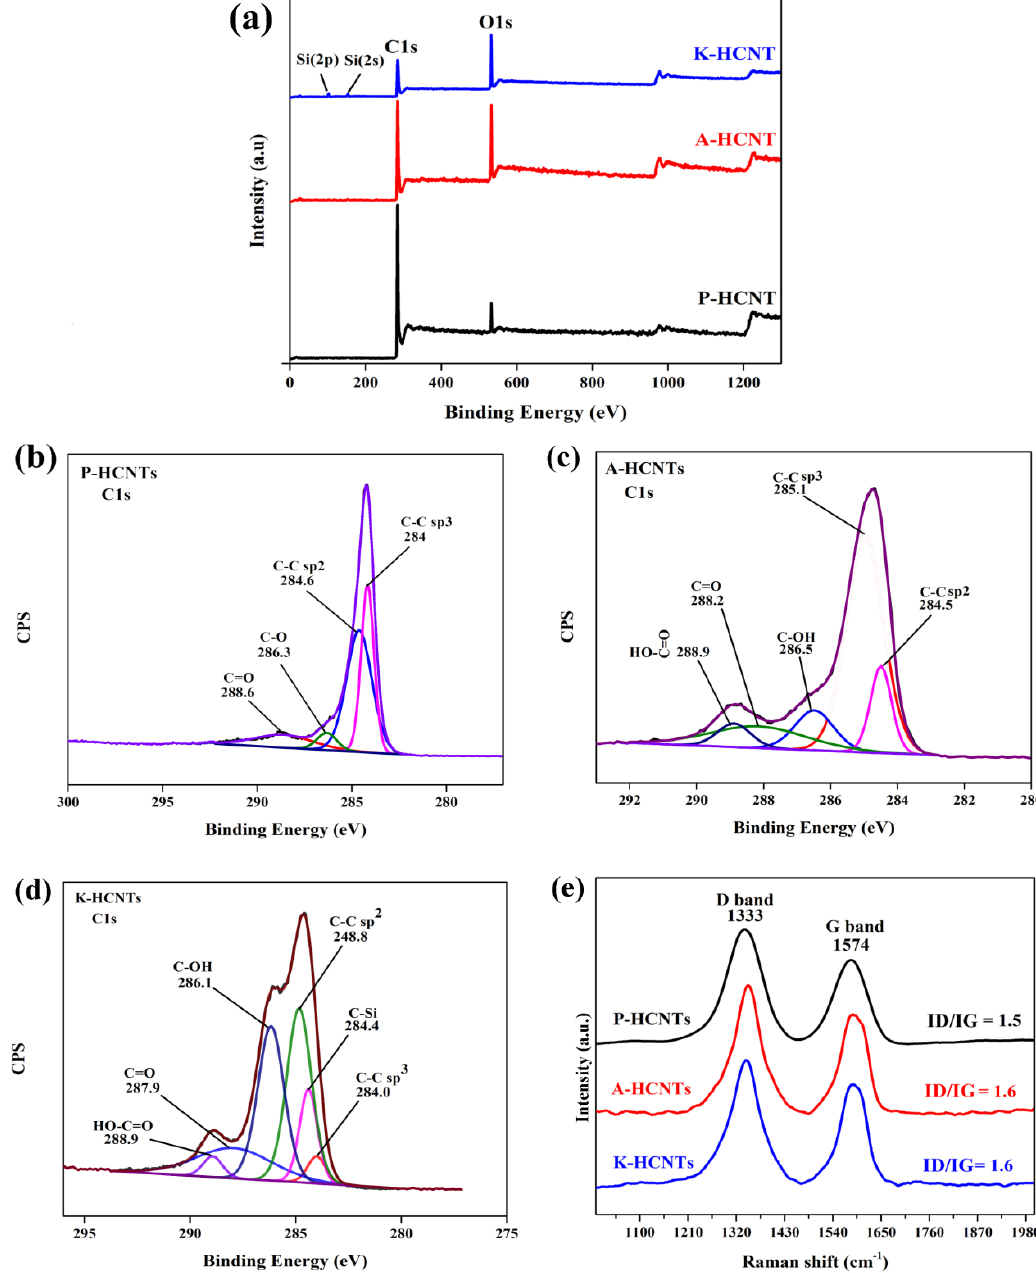
Figure 4. Effect of surface treatments on the surface chemical properties and the defect degree of HCNTs. X-ray photoelectron spectroscopy (XPS) survey spectra ( a ) of P-HCNTs, A-HCNTs and K-HCNTs. High-resolution XPS C1s spectra of P-HCNTs ( b ), A-HCNTs ( c ) and K-HCNTs ( d ). Raman spectra ( e ) of P-HCNTs, A-HCNTs and K-HCNTs.